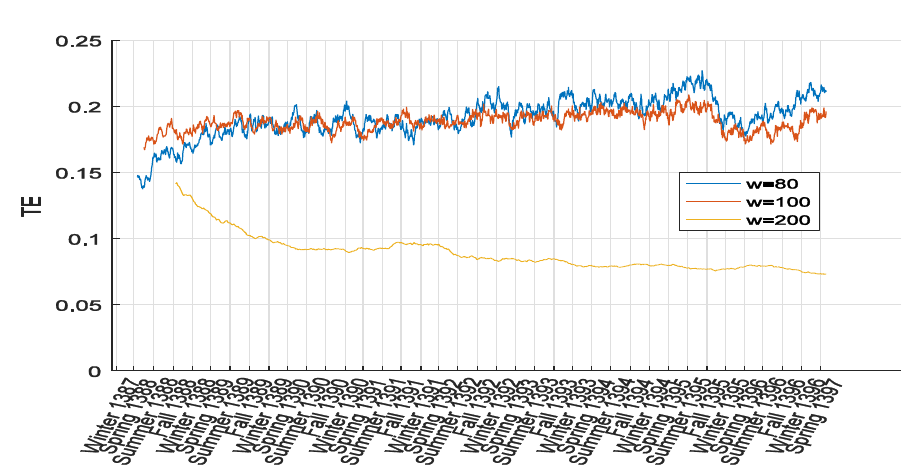
Figure 8. Time series Average information transmitted along with different scales for 180 companies in the Tehran stock market.